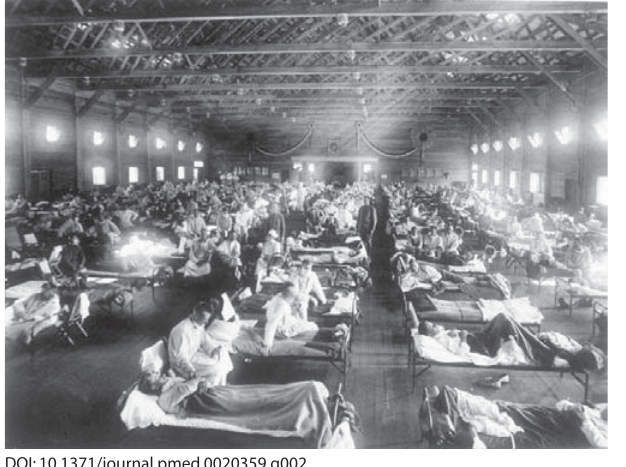
Figure 2. Emergency Hospital during 1918 Infl uenza Epidemic, Camp Funston, Kansas, United States (Photo: Image “NCP 1603,” National Museum of Health and Medicine, Armed Forces Institute of Pathology, Washington,